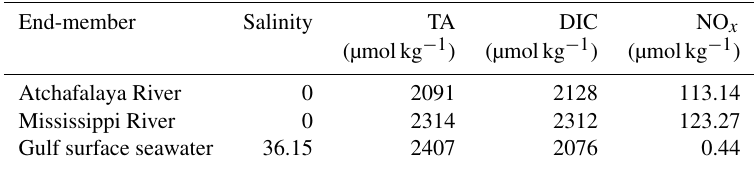
Table 1. The end-member properties used in the three-end-member mixing model. End-member Salinity TA DIC 0 Mississippi River 0 2314 2312 Gulf surface seawater